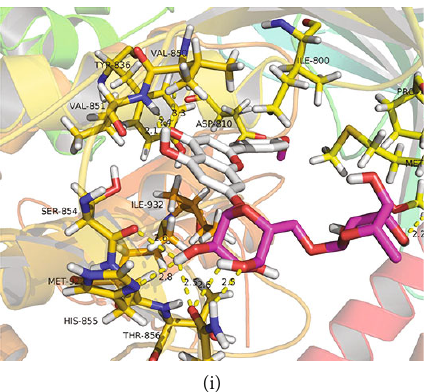
Figure 6: Molecular models of binding of bioactive compounds to the core targets. (a) MOL000006 to MAPK8; (b) MOL001790 to EGFR; (c) MOL005169 to AKT1; (d) MOL001790 to SRC; (e) MOL000006 to ESR1; (f) MOL005209 to RELA; (g) MOL005188 to RAC1; (h) MOL000006 to IGF1R; (i) MOL001790 to